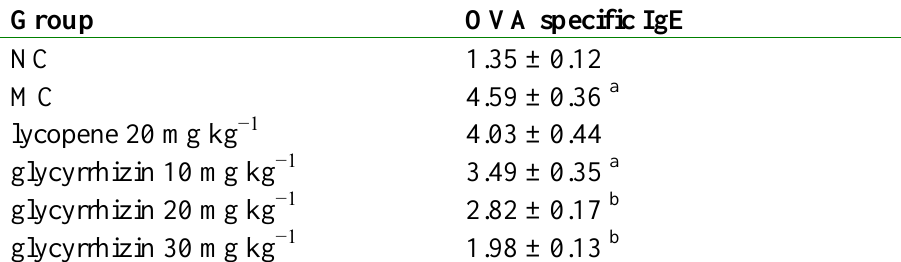
Table 2. OVA specific IgE levels in different